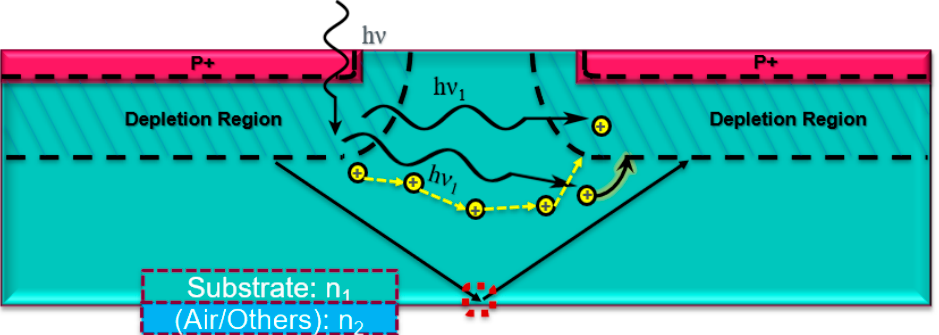
Figure 10. Crosstalk in a SPAD array without isolation (dashed arrow: electrical crosstalk; solid arrow: optical crosstalk).